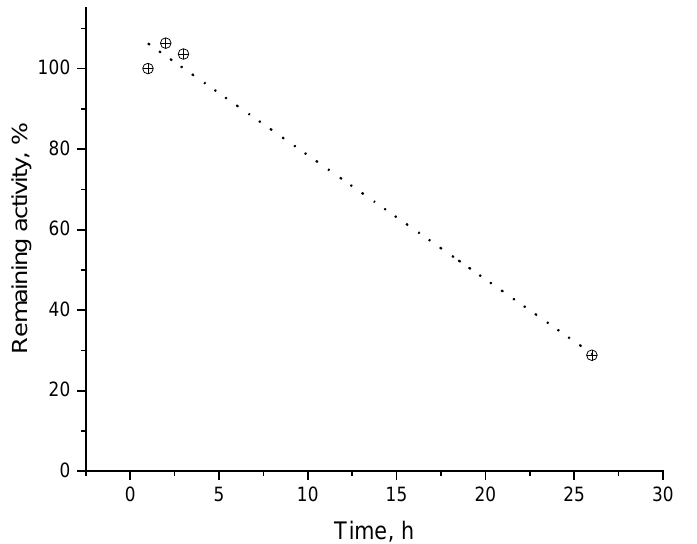
Figure 10. Remaining catalytic activity as a function of the time passed since biosensor fabrication. The data were normalized to the first measurement at E = − 0.1 V in citrate buffer, pH = 4.0: substrate— dopamine.